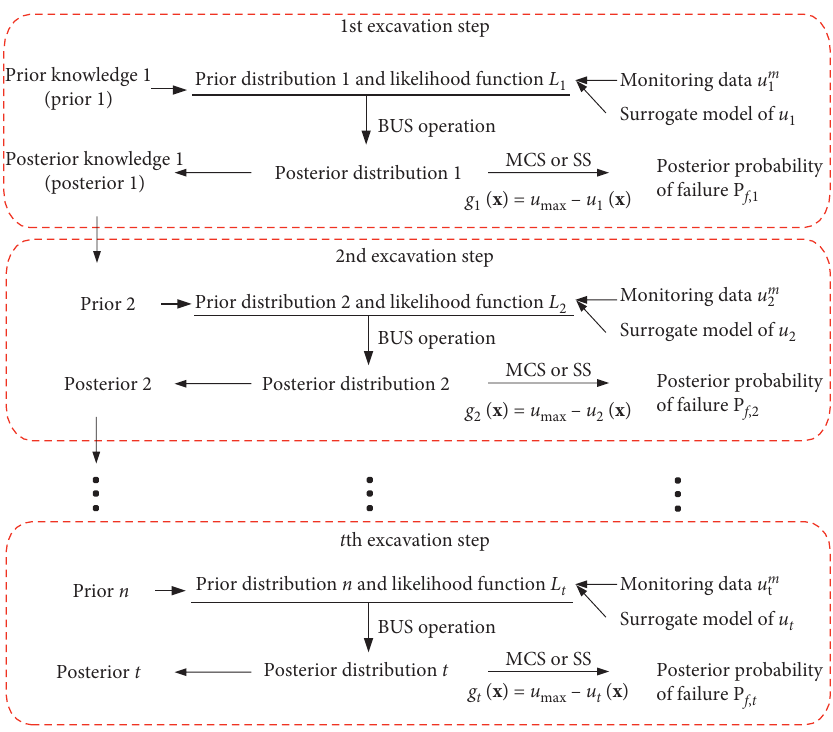
Figure 1: Flowchart of BUS-based sequential probabilistic back analysis and reliability updating